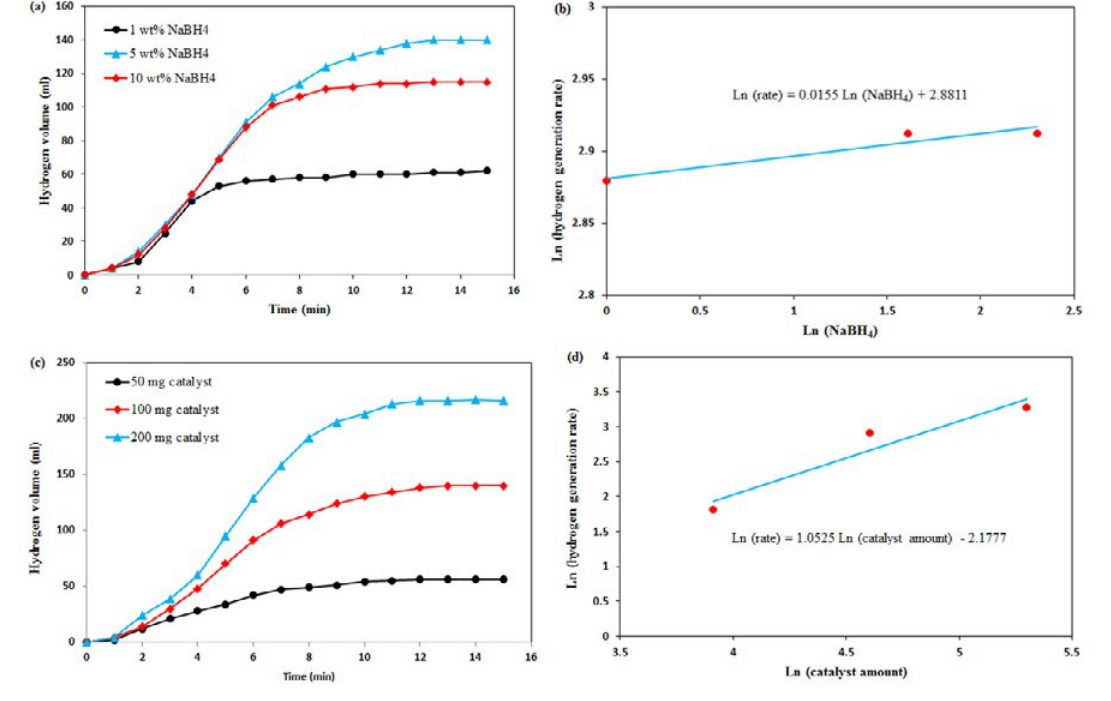
Fig. 8. (a) Effect of NaBH concentration on hydrogen generation and (b) Ln (hydrogen generation rate) as a function Ln (NaBH 4 Influence of catalyst amount on hydrogen generation and (d) Ln (hydrogen generation rate) as a function Ln (catalyst